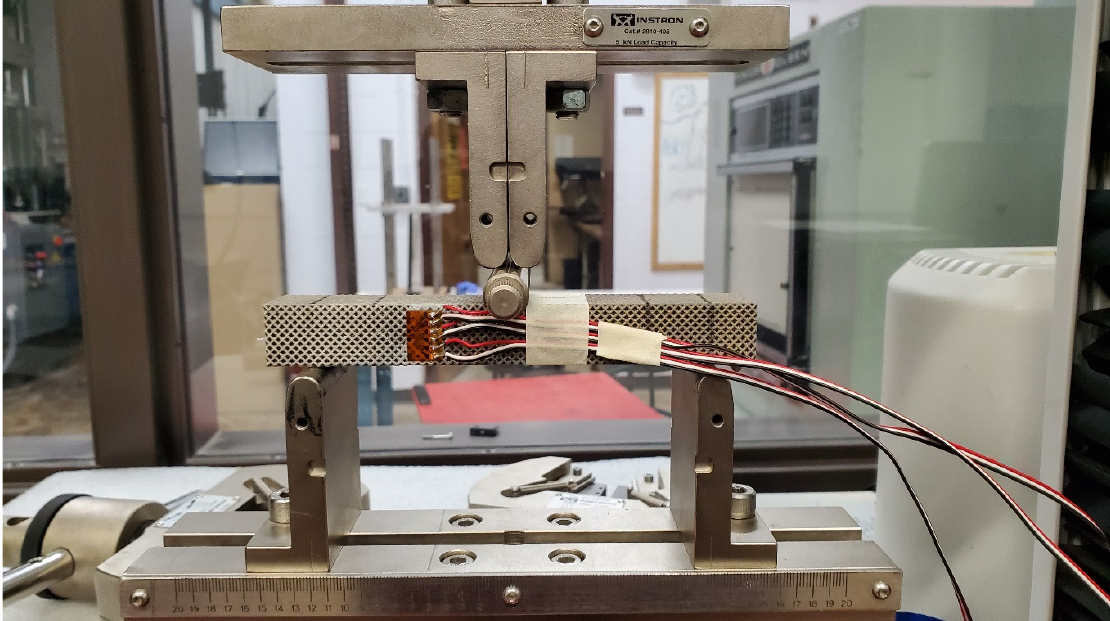
Figure 4. Bending test for shear modulus validation.